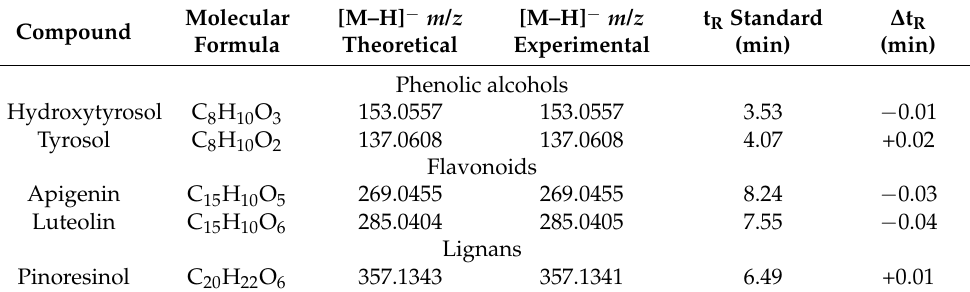
Table 1. Target screening